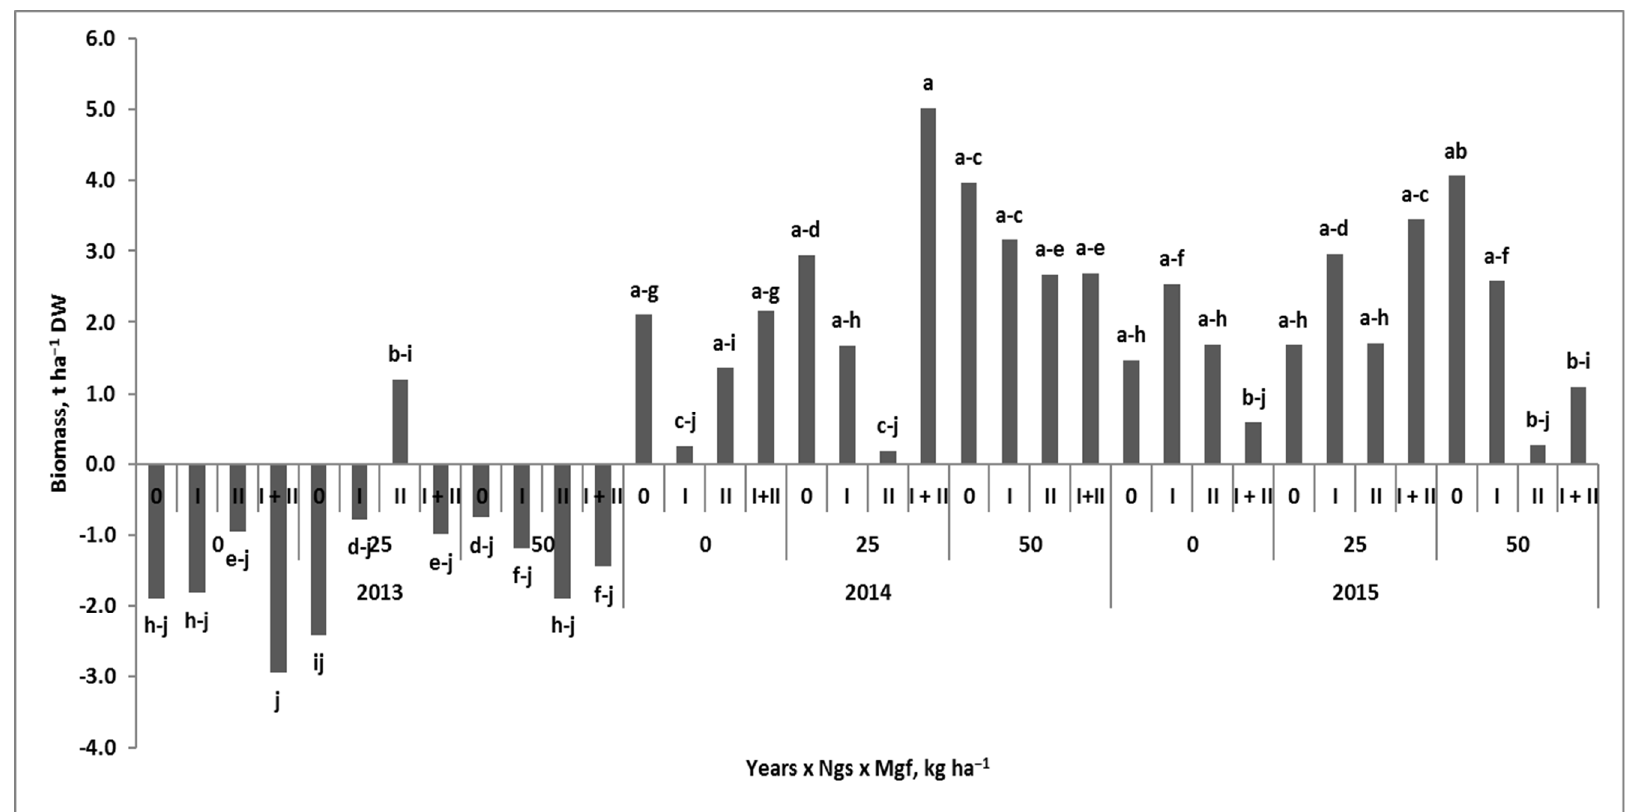
Figure 9. Effect of magnesium fertilization systems on the background of years on the current photosynthesis of winter wheat from BBCH 58 to BBCH 79. Similar letters mean a lack of significant differences using Tukey’s test. Legend: Mgs, Mgf—soil and foliar Mg fertilization systems, respectively; I—BBCH 30; II—BBCH 49/50.